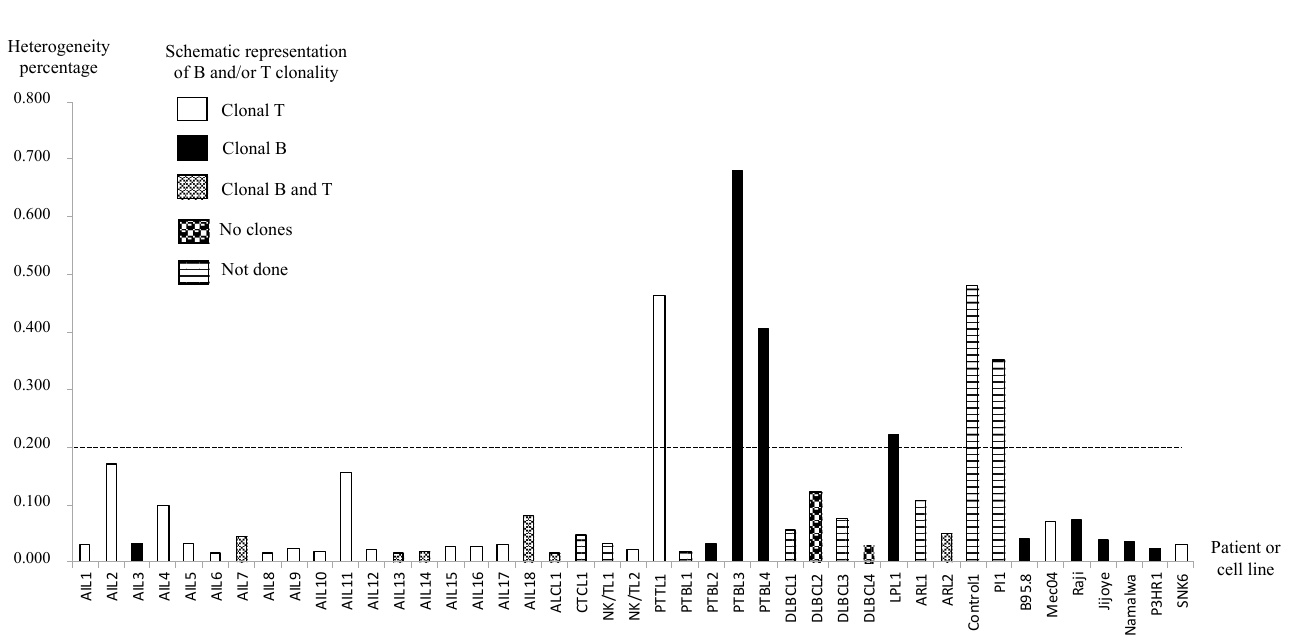
Figure 3. EBV clonality in AITL and other lymphoma samples. Viral clonality was assessed based on the work of Kwok et al. [33]. B and/or T clonality is also represented for each